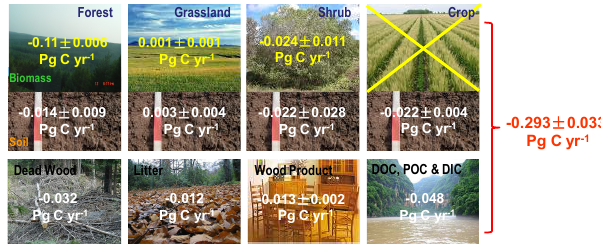
Fig. 3. The inventory- and satellite-based approach estimated a car- bon sink in terrestrial ecosystems in East Asia and its components over the last two decades. A negative value indicates net carbon